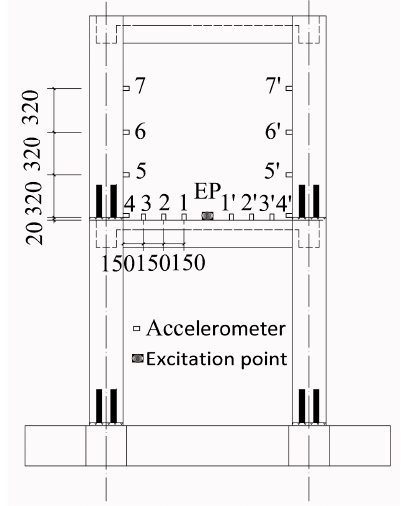
Figure 16. Locations of accelerometers and excitation point in case 6.